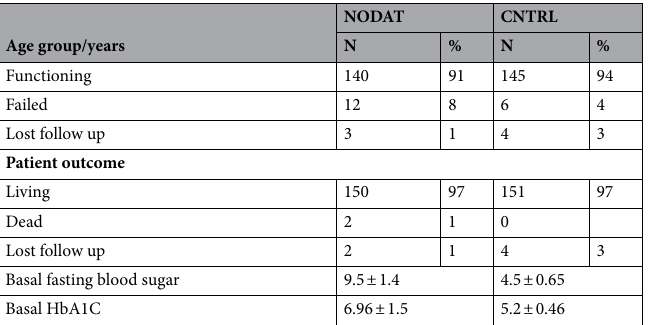
Table 1. Characteristics of studied subjects. General characteristics of study groups and their distribution among NODAT and control.